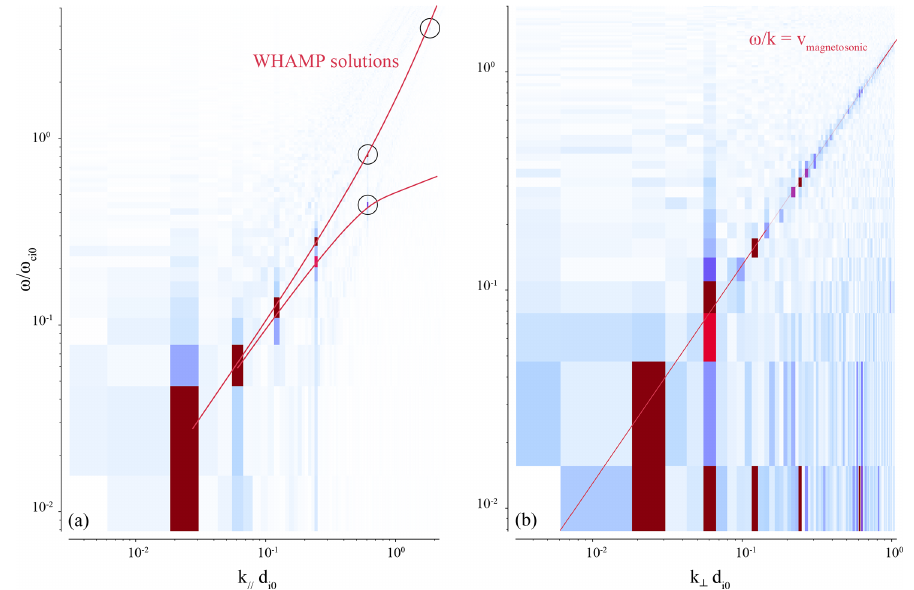
Figure 2. MHD modes dispersion relations, as solved by WHAMP and Menura . B 0 = 1 . 8nT, n 0 = 1 . 0cm − 3 , T i0 = 10 4 K, T e0 = 10 5 K. (a) Alfvénic modes, B 0 taken along the main spatial dimension. (b) Magnetosonic modes, B 0 taken perpendicular to the main spatial dimension.